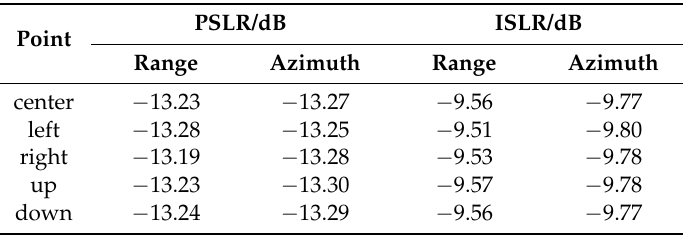
Table 5. Evaluation of GRFT-based point target imaging.